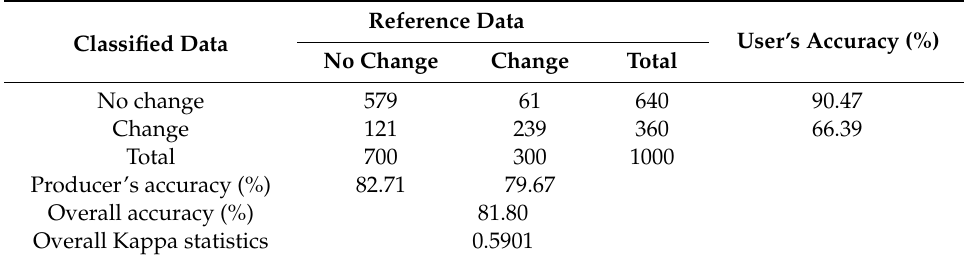
Table 10. Binary change detection error matrix for the ECVA_PB